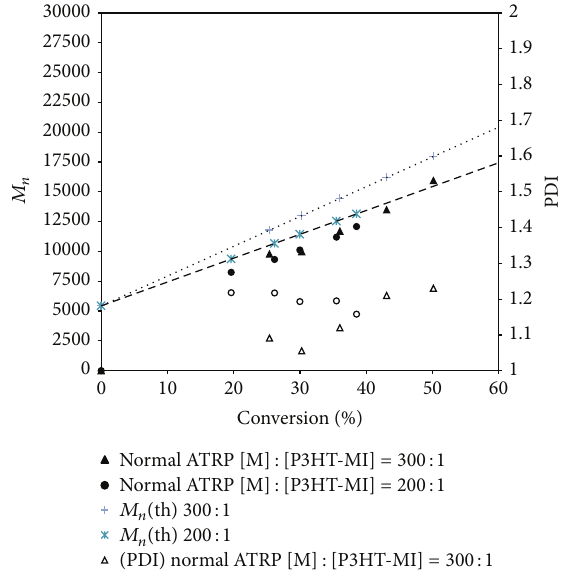
Figure9:Dependenceofmolecularweightandpolydispersityindex on monomer conversion for the ATRP of styrene and CMS with the P3HT macroinitator (using different monomers/macroinitiator mole ratios).